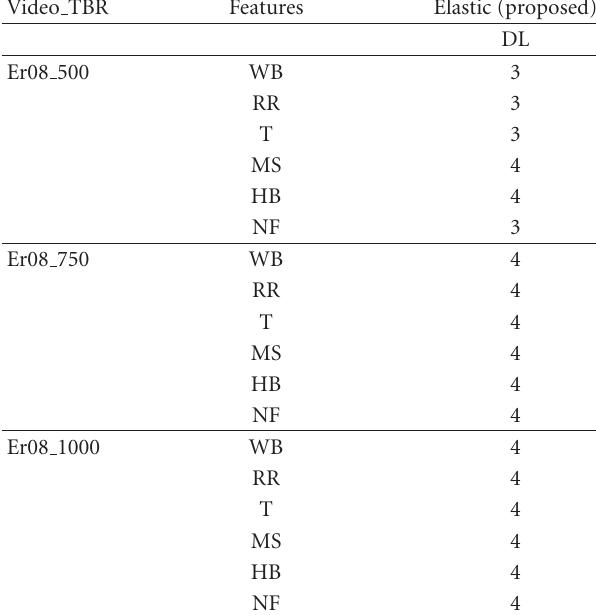
Table 6: Evaluation of video Er08 when ROI coded (diagnostic level quality scale: 1-no, 2-maybe not, 3-likely, 4-yes).